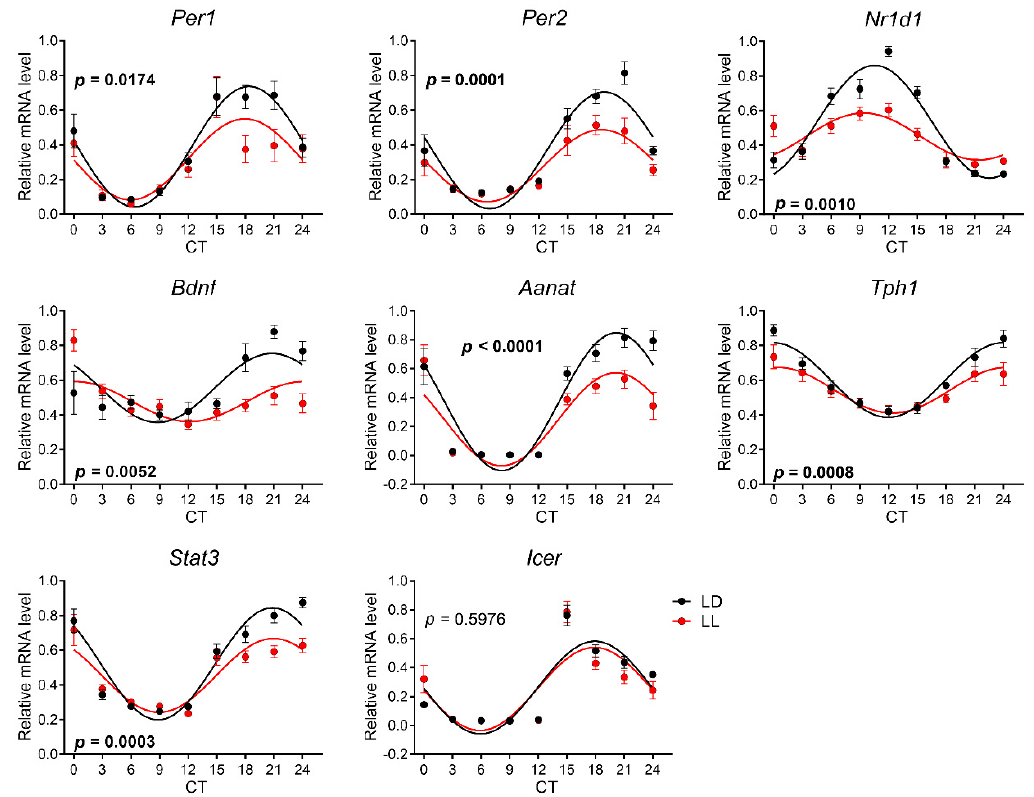
Figure 6. Effect of development under constant light (LL, in red; controls in LD in black) on rhythmic gene expression in the pineal gland at P30. Animals were housed under LL (16 lux) from P0 until P20 and then released into LD conditions. At P30, the animals were sacrificed in 3 h intervals in DD, and pineal glands were processed by qPCR with specific TaqMan probes. Rhythmicity was proved by cosinor analysis with the horizontal line as zero hypothesis and one-way ANOVA for the differences between time groups. Full lines indicate the rhythms confirmed by cosinor analysis and one-way ANOVA. Each point represents the mean ± SEM from six to eight animals. p -values indicate the group differences by two-way ANOVA, and significant values are in bold.